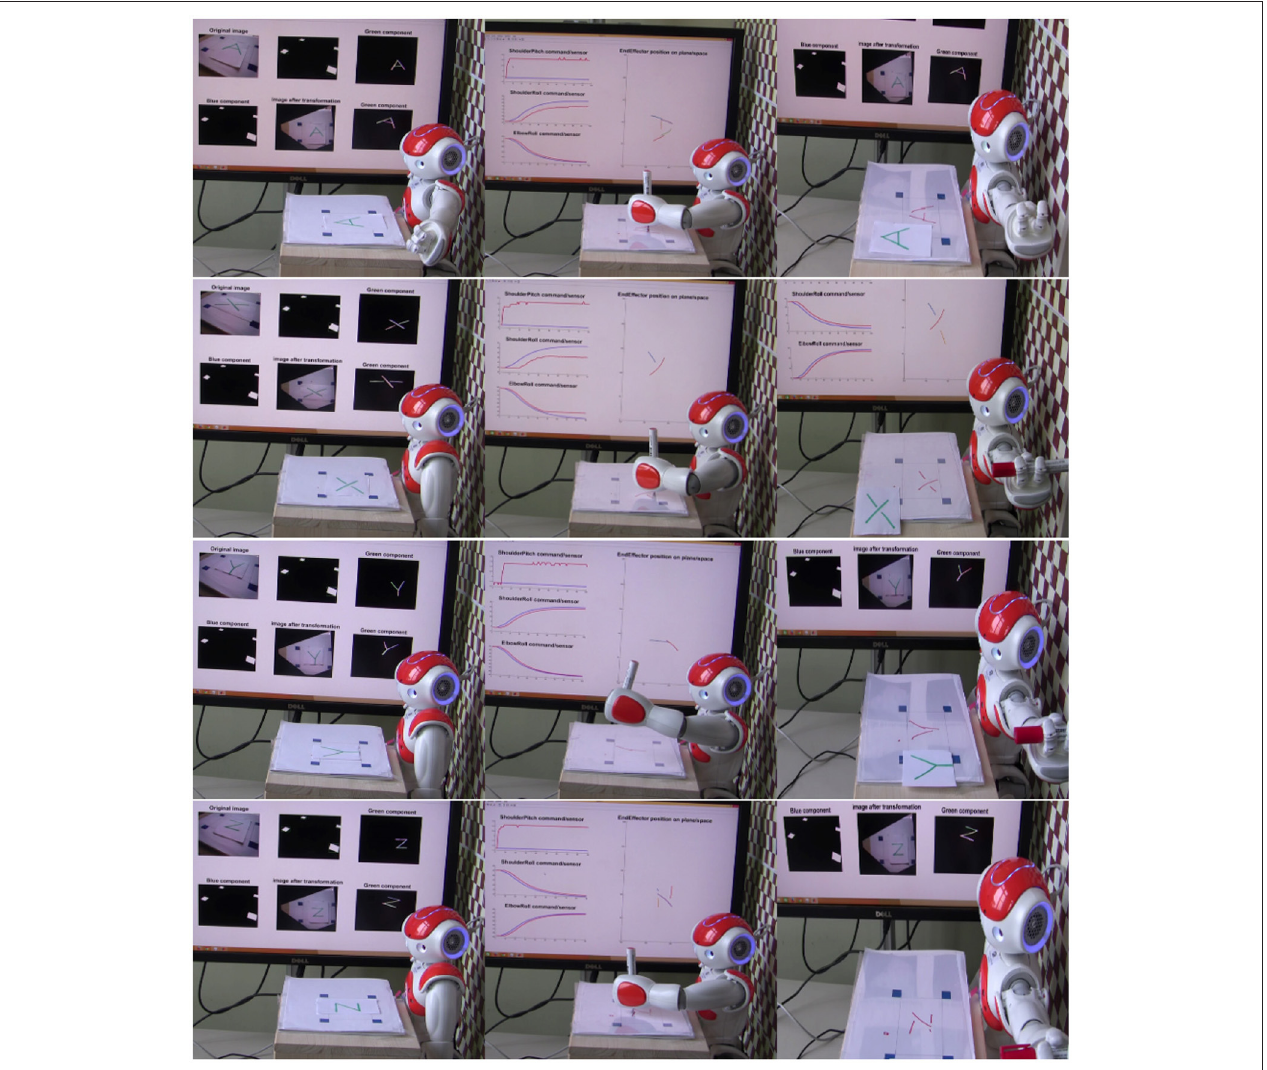
FIGURE 8 | NAO draws letters A, X, Y, and Z that consist of only straight lines. A video is available on: https://www.tu-chemnitz.de/informatik/KI/edu/robotik/videos/ TMCRDT.mp4.